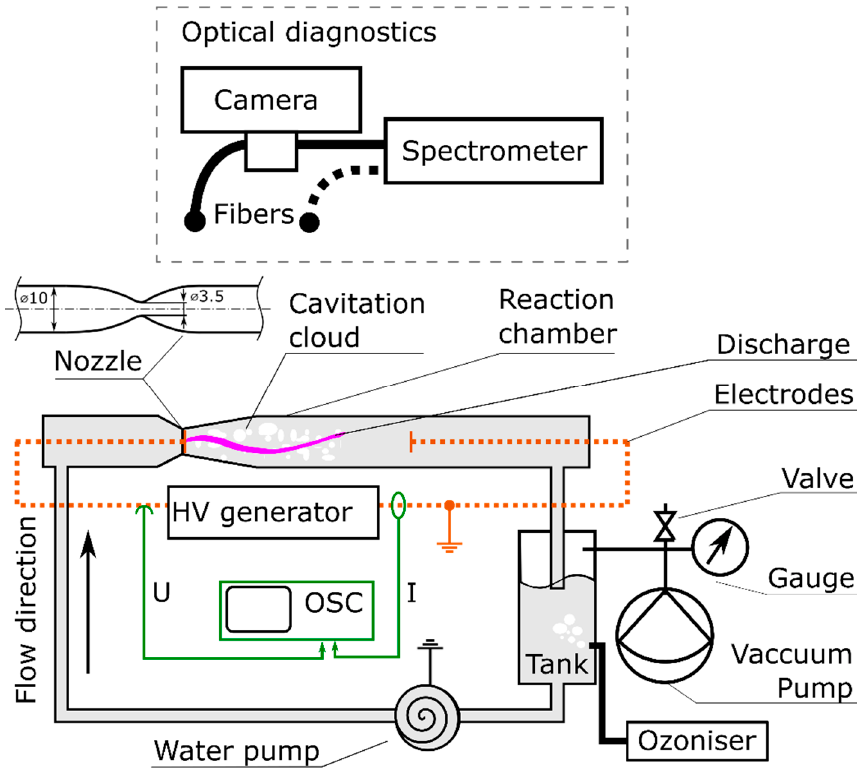
Figure 2. Experimental setup consisting of the HCPJ unit, vacuum unit, ozoniser, and electrical/optical diagnostics. For details, see Section 2.1.